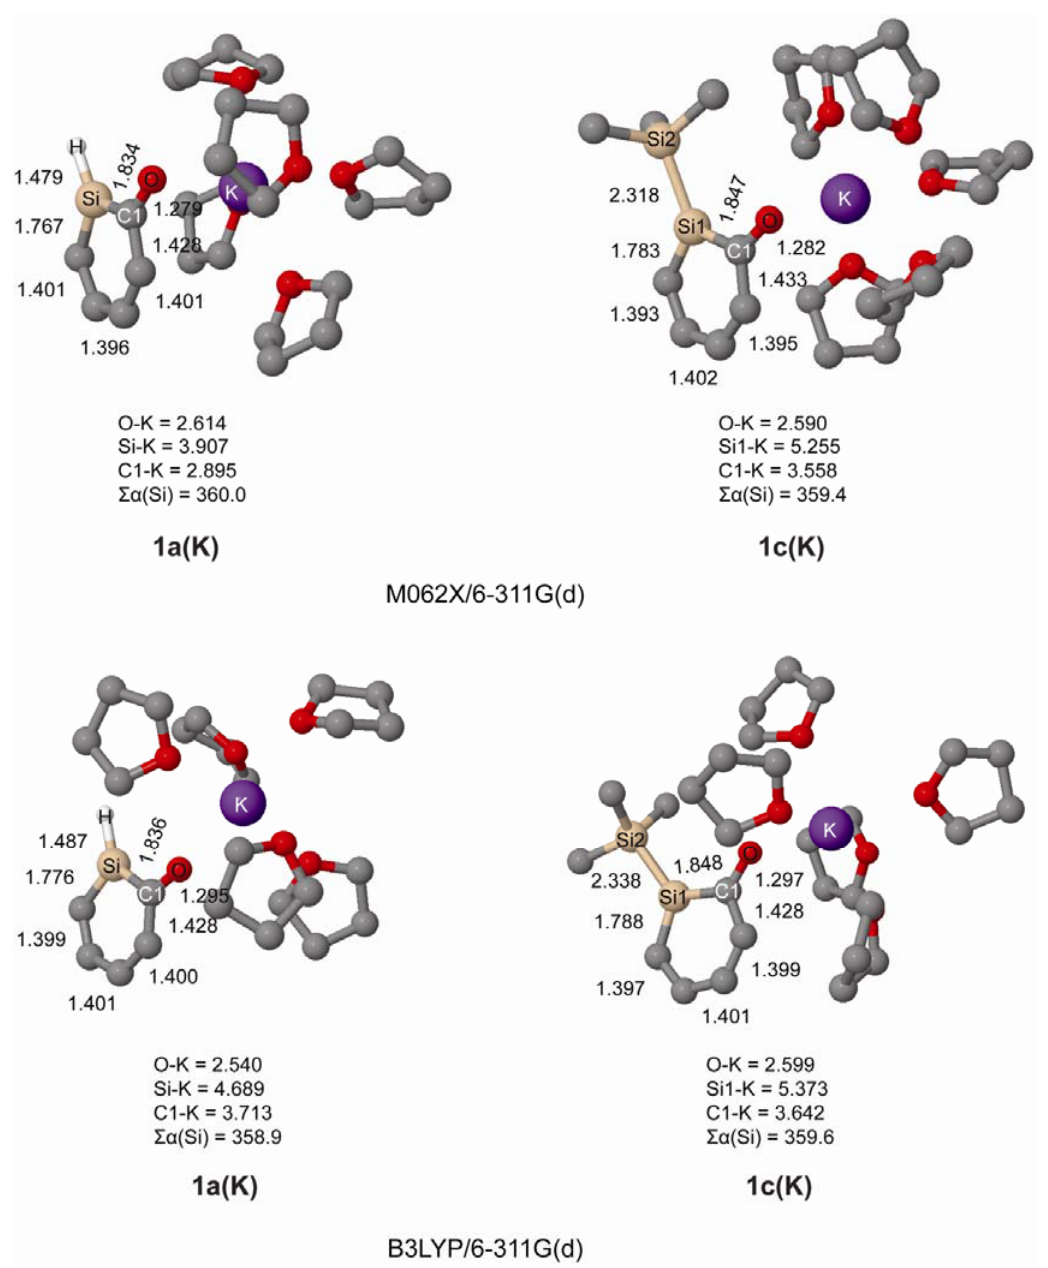
Figure 2. Geometries of K + (THF) solvated silaphenolates 1a(K) and 1c(K) calculated at 5 M062X/6-311G(d) (top) and B3LYP/6-311G(d) (bottom) levels of computation. Bond lengths in Å and sum of valence angles (  (Si)) in degree. Hydrogen atoms omitted for